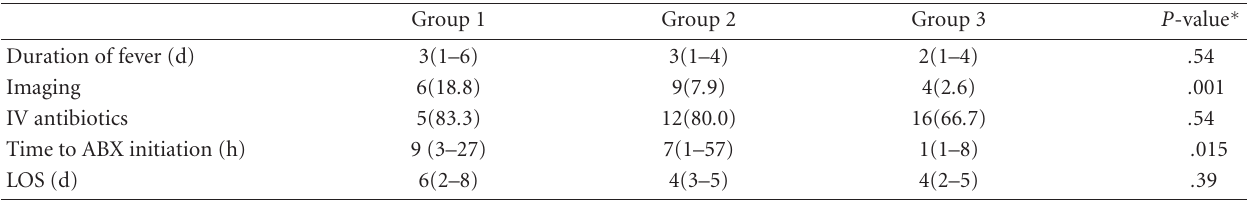
Table 3: Management of febrile morbidity. †